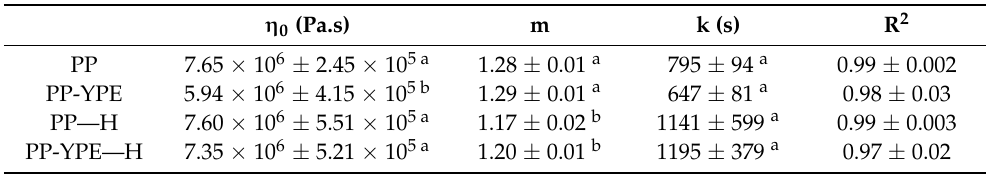
Table 4. Rheological parameters of the flow curves adjusted to the Williamson equation. Values are presented as mean ± standard deviation ( n = 3). For each column, values with the same letter are not statistically different ( p >